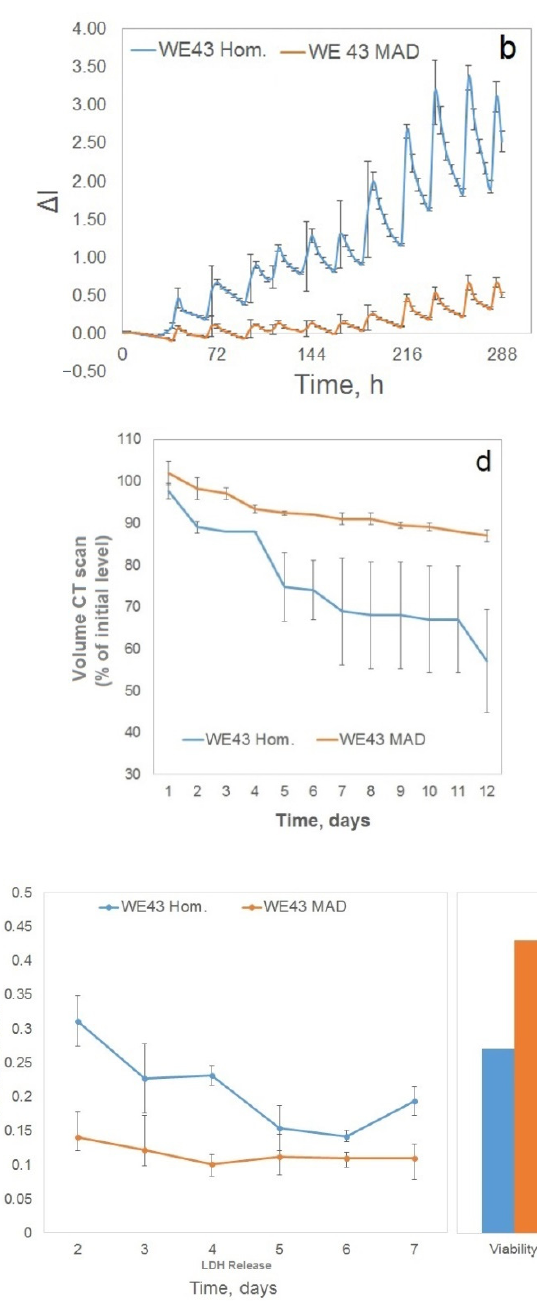
Figure 4. Dynamic of the accumulation of biodegradation products for WE43 Hom. and WE43 MAD in fetal bovine serum ( a ) and in complete growth cell culture medium ( b ). The dynamic of the pH value of the corrosion environment for alloys WE43 Hom. and WE43 MAD in FBS and in complete growth medium ( c ). Variation in the volume CT scan during incubation in FBS ( d ). The dynamic of Housefield unit values of the samples during the incubation of alloy samples in FBS ( e ). Dynamic of the cytotoxicity of WE43 alloy samples in initial state and after MAD according to the results of the LDH release, and the cell viability after 7 days of incubation of MMSCs seeded on alloys according to the LDH activity data ( f ). Data are presented as a mean ± SD.